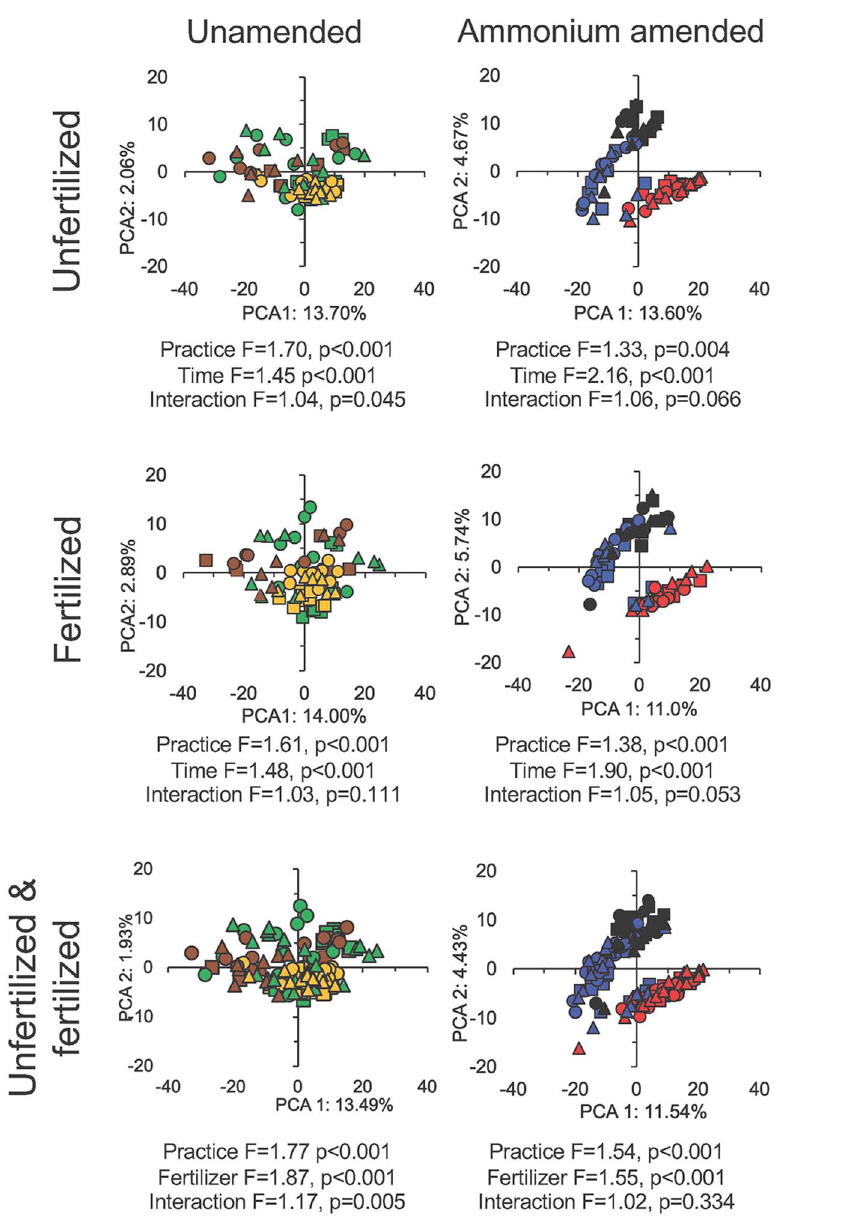
Figure 2. Principal component analysis (PCA) with the converted sequence counts of all bacterial groups classified up to the genus level using the centred log-ratio transformation (aldex.clr argument, ALDEx2 package 14 ) in the unfertilized soil or soil fertilized with 300 kg urea-N ha −1 left unamended with conventional tilled beds (CT) at day 0, 1 and 3 (filled green square), at day 5, 7 and 14 (filled orange square) and at day 28 and 56 (filled brown square), permanent beds with crop residue burned (PBB) at day 0, 1 and 3 (filled green circle), at day 5, 7 and 14 (filled orange circle) and at day 28 and 56 (filled brown circle) and permanent beds with crop residue retained (PBC) at day 0, 1 and 3 (filled green triangle), at day 5, 7 and 14 (filled orange triangle) and at day 28 and 56 (filled brown triangle) or amended with 300 mg NH 4+ -N kg −1 dry soil with CT at day 0, 1 and 3 (filled red square), at day 5, 7 and 14 (filled blue square) and at day 28 and 56 (filled black square), PBB at day 0, 1 and 3 (filled red circle), at day 5, 7 and 14 (filled blue circle) and at day 28 and 56 (filled black circle) and PBC at day 0, 1 and 3 (filled red triangle), at day 5, 7 and 14 (filled blue triangle) and at day 28 and 56 (filled black triangle), incubated aerobically at 25 ± 2 °C for 56 days. F and p values were determined with a perMANOVA